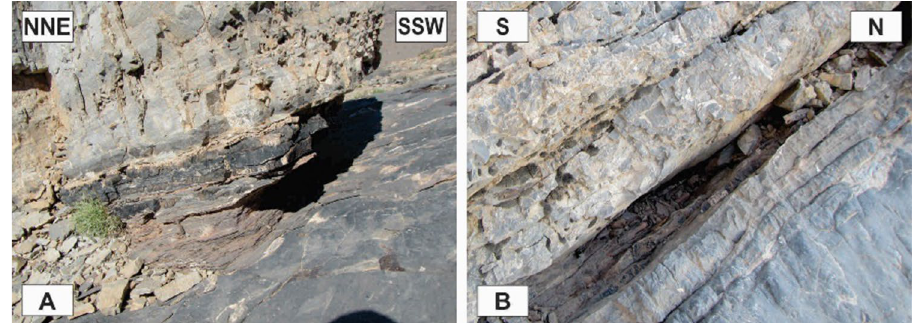
Figure 15. The Layer-parallel ductile shear zones. (Photos are taken by Mohammad Ali